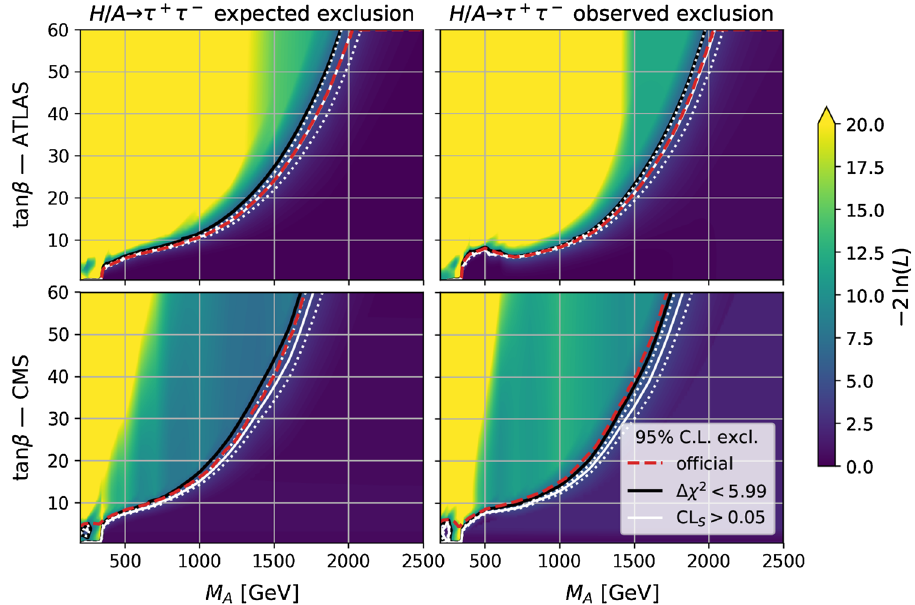
comparison, the red-dashed lines show the official 95%